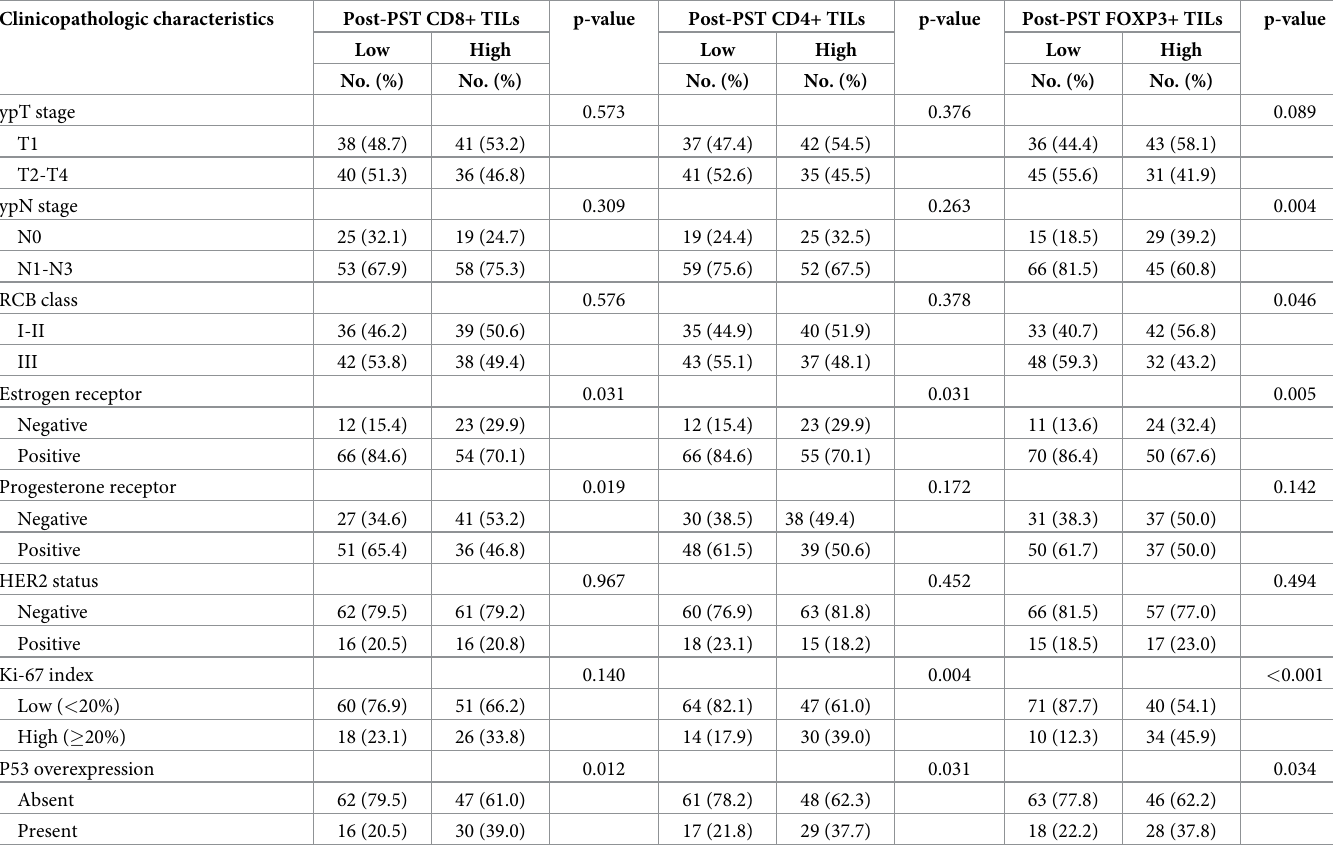
Table 3. Relationship between infiltration of tumor-infiltrating lymphocyte subsets after primary systemic therapy and post-treatment clinicopathological features of tumor. Clinicopathologic